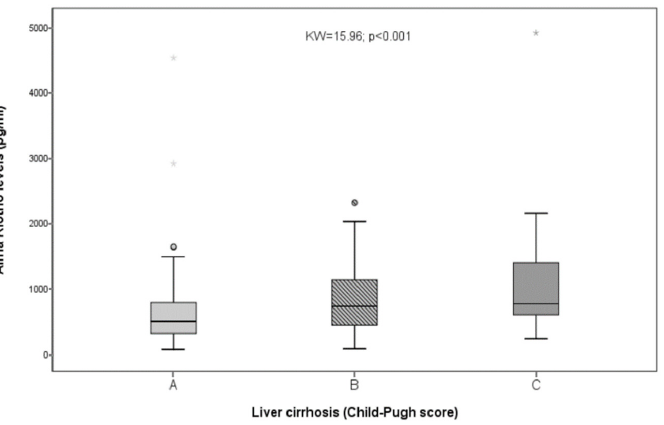
Figure 2. Differences in Klotho values among Child A, B, and C patients. As shown, statistically significant differences were observed when the three groups were compared (KW = 15.96; p < 0.001), ° = represent extreme values.